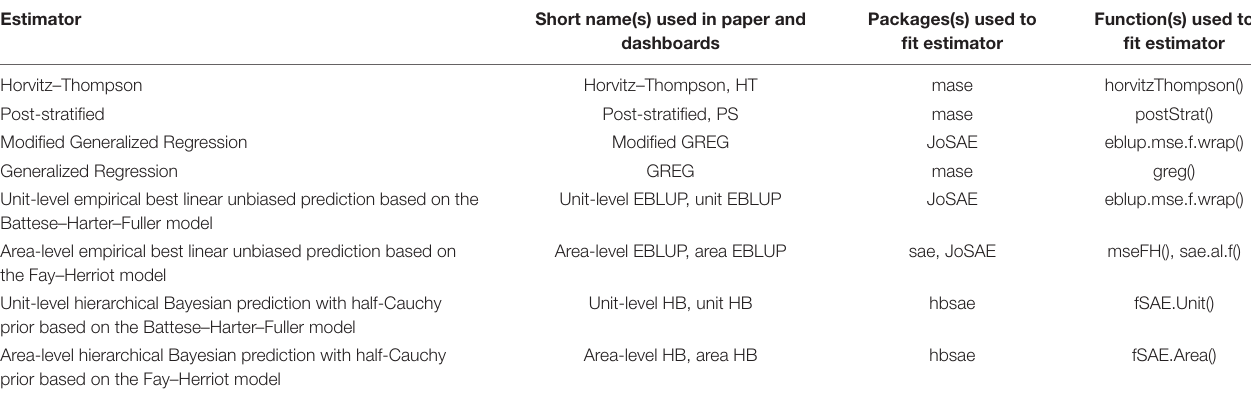
TABLE 1 | Estimators and associated short names/acronyms, R packages, and specific R functions within those packages. Estimator Short name(s) used in paper and